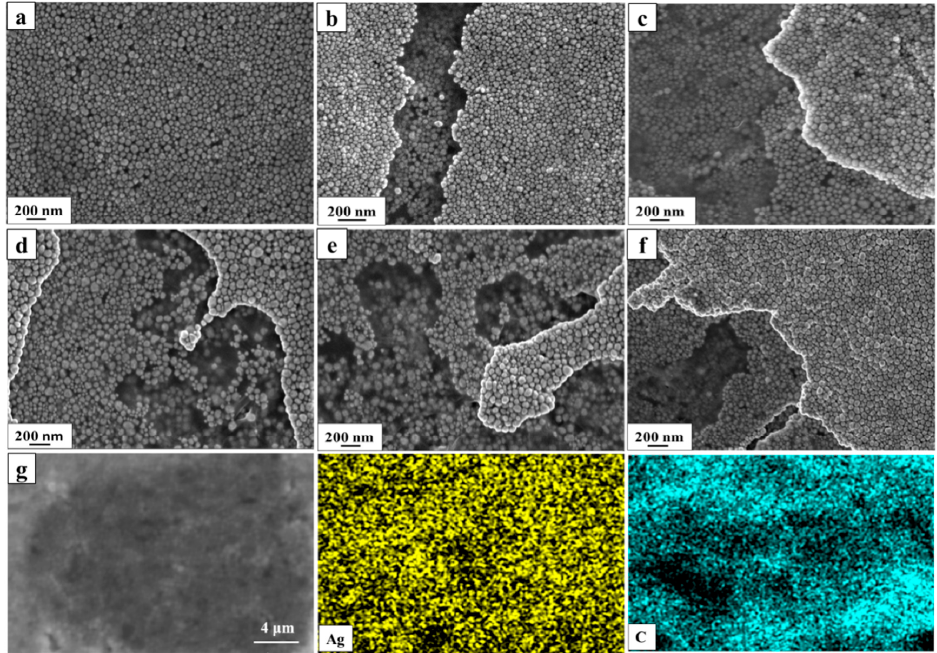
Figure 3. SEM images of the multilayer substrate with ( a ) one chemical mechanism (CM)–electromagnetic mechanism (EM) unit, ( b ) two CM–EM units, ( c ) three CM–EM units, ( d ) four CM–EM units, ( e ) five CM–EM units, and ( f ) six CM–EM units. ( g ) Energy dispersive spectrometer (EDS) elemental maps for the Ag and C on the multilayer